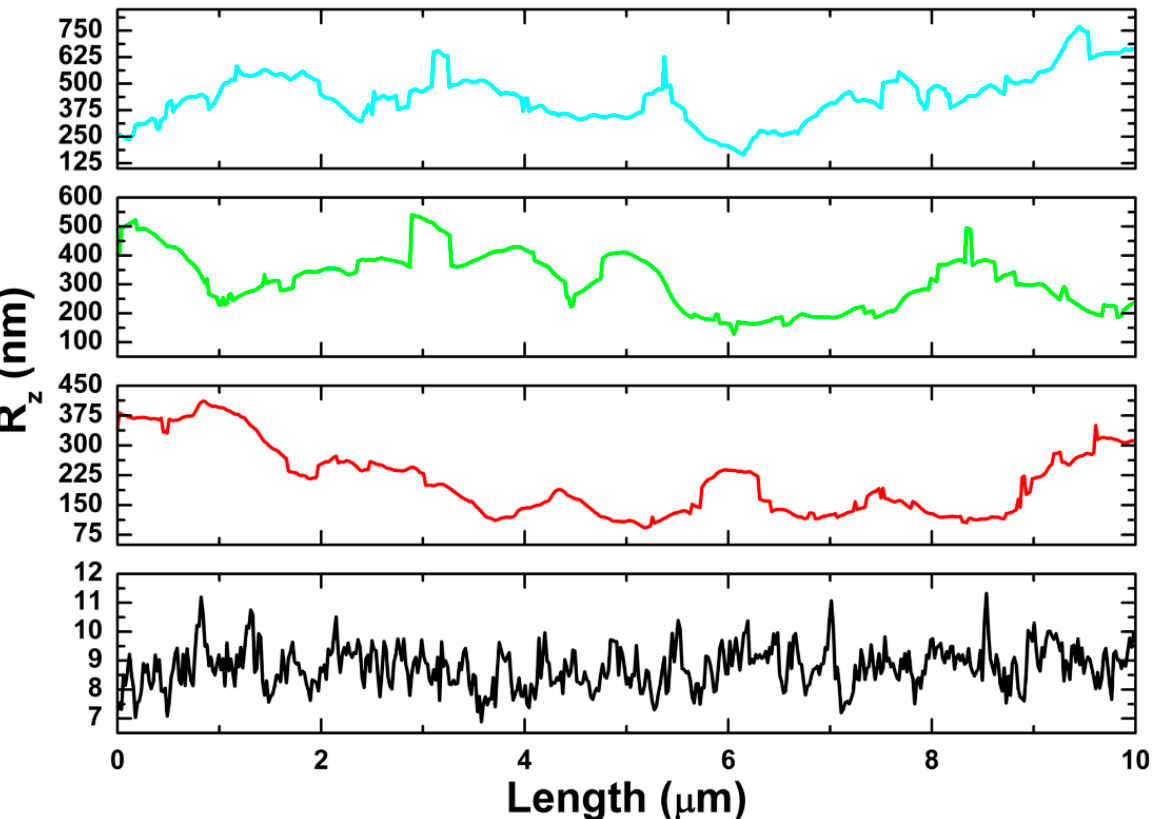
Figure 2. Maximum height of the profile acquired from AFM images.